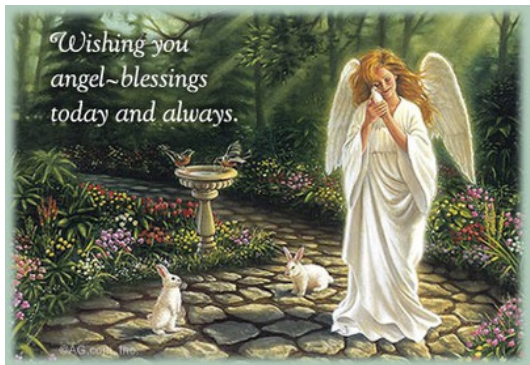
Figure 6. “Wishing you angel-blessings today and always” [16]. This picture was published on a memorial website for Ehline, who committed suicide in 2007 at age